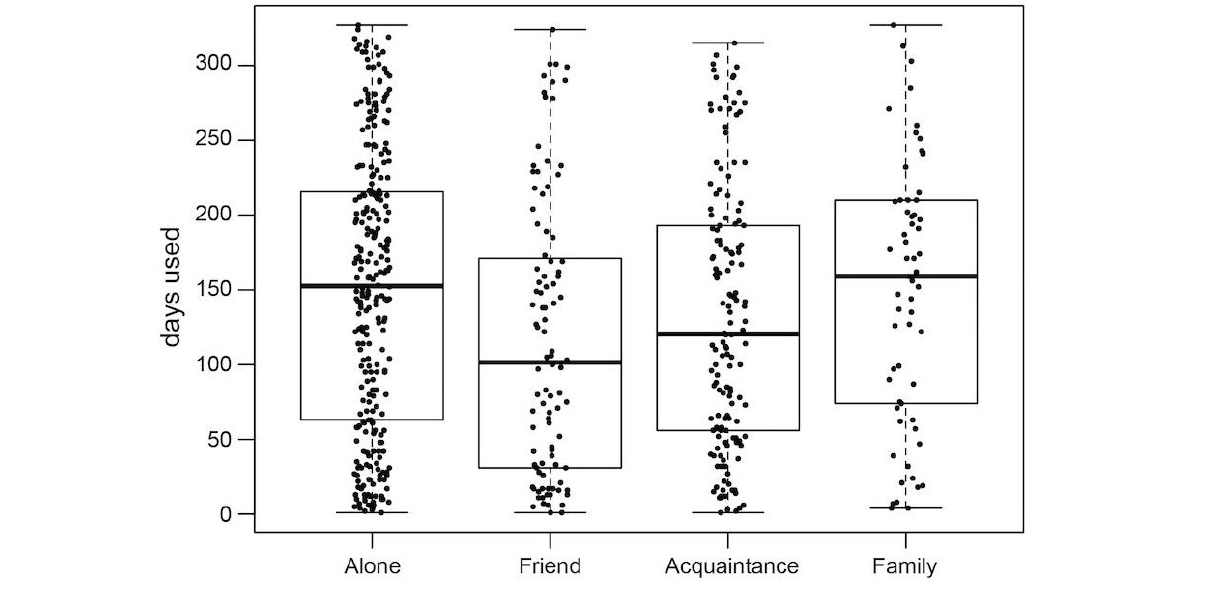
Figure 9. Boxplots of the distributions of Sports in company of others. Those who practice individual sports or with relatives, have longer sustained use of the tracker than those who participate in sports with friends or